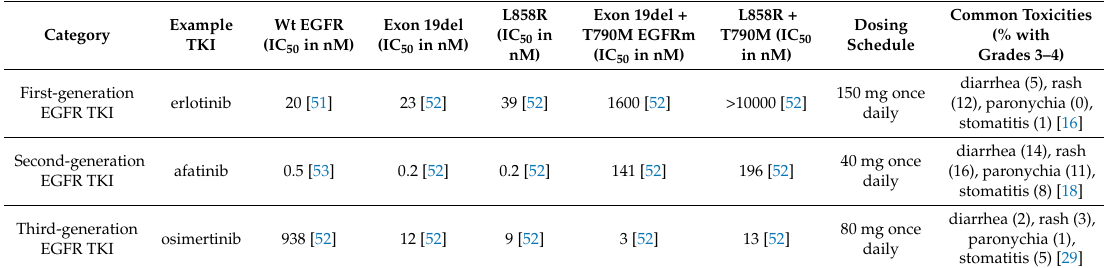
Table 1. Binding affinity, dosing, and toxicities of EGFR tyrosine kinase